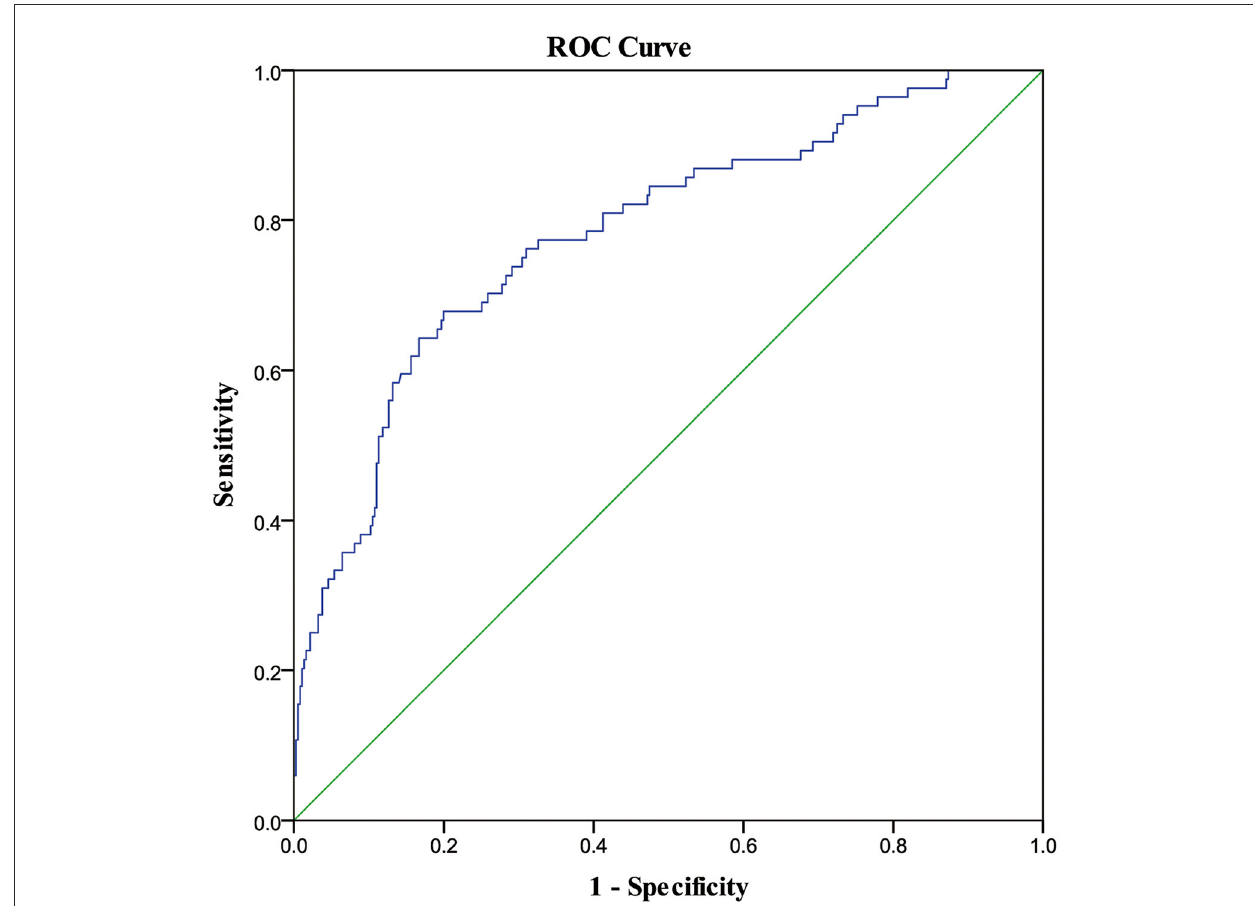
FIGURE2 ROC curve of the risk factors associated with deep venous thrombosis. ROC, receiver operating characteristic curve; AUC, area under the curve. The blue curve represents the ROC curve of the multi-factor analysis model for postoperative risk factors associated with deep venous thrombosis. The AUC was 0.78 (95% CI: 0.73–0.84, P <